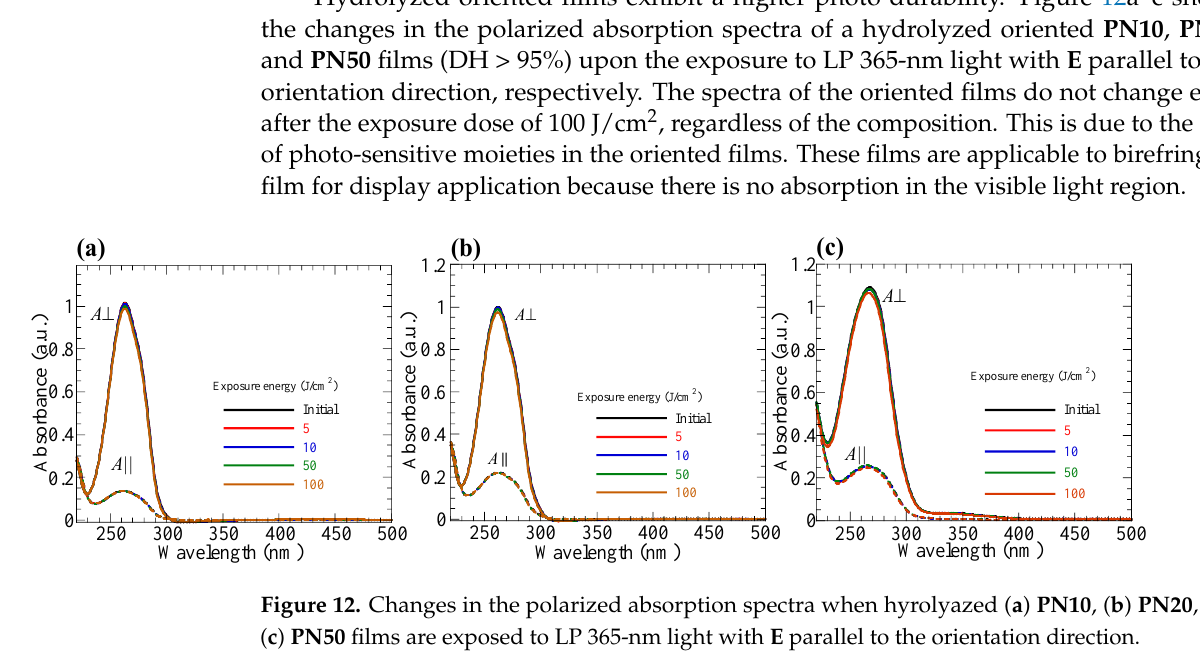
Figure 11. Changes in the polarized absorption spectra when oriented ( a ) PN10 , ( b ) PN20 , and ( c ) PN50 films are exposed to LP 365-nm light with E parallel to the orientation direction. Insets plot the D values as a function of exposure energy.